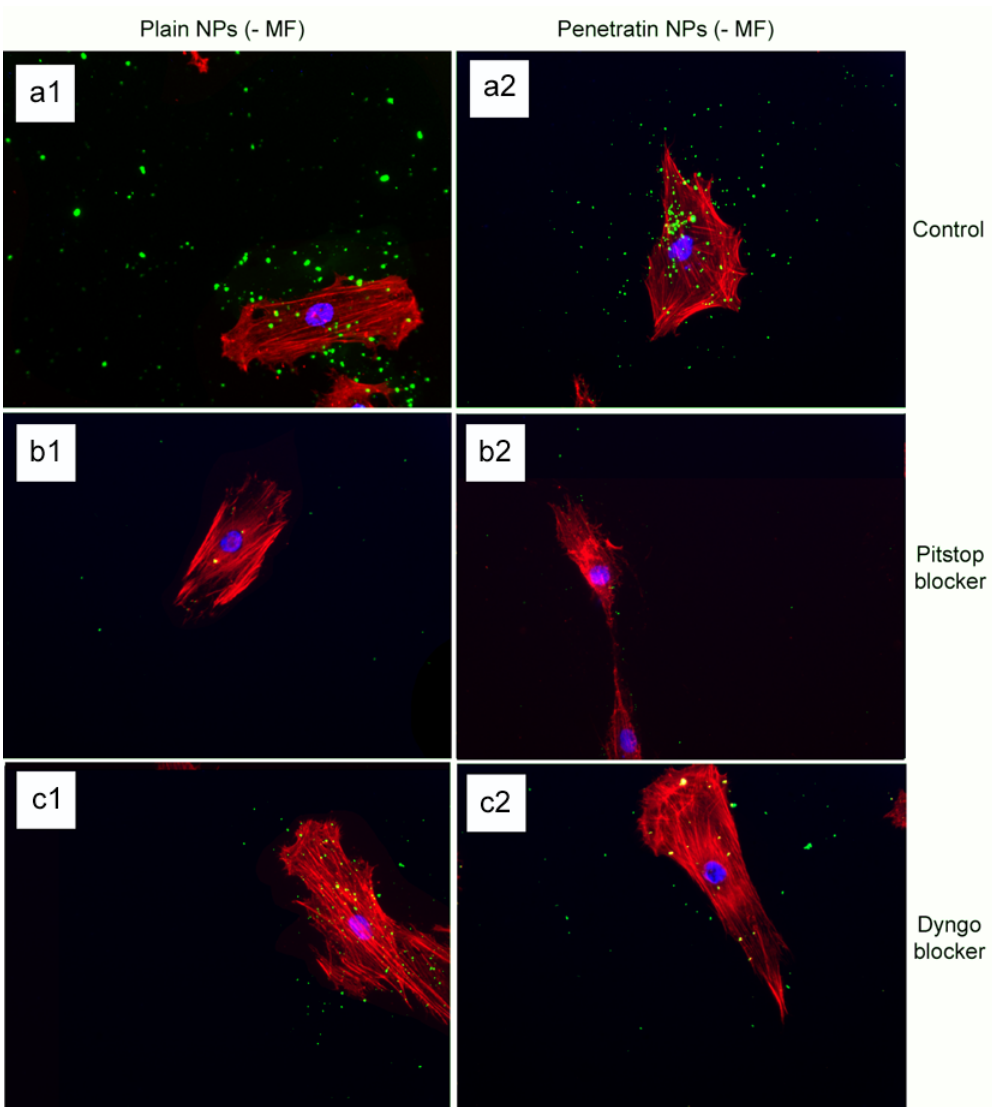
Figure 7 . Fluoresence microscopy of plain and penetratin 200 nm particle uptake into cells in the absence of a magnetic field, incubated with either Pitstop or Dyngo endocytosis